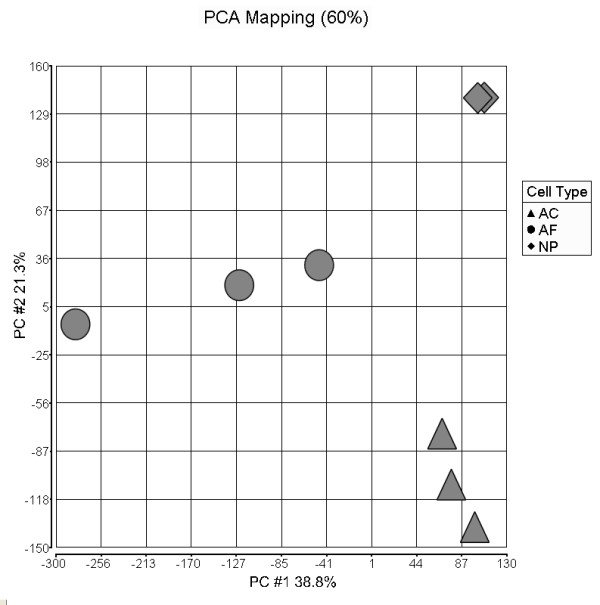
Principal component analysis (PCA) of microarray data set. Overall variation between the three cell types articular cartilage (AC; triangles), annulus fibrosus (AF; circles) and nucleus pulposus (NP; diamonds), where each spot represents an individual array, can be seen by the clustering within each cell type and the separation between the different cell types.